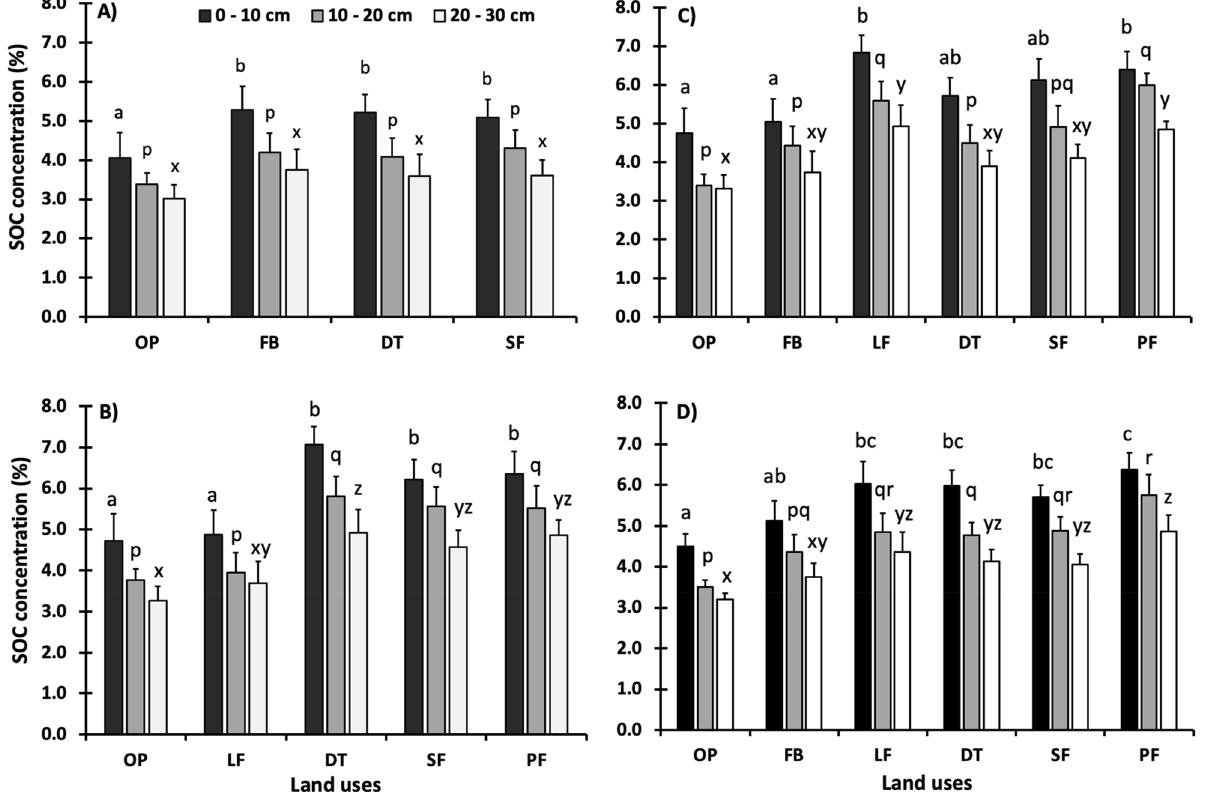
Figure 3. Soil organic carbon (SOC) content (%) across sampled land uses by soil depth category. ( A ) Jalisco, ( B ) Campeche, ( C ) Chiapas, ( D ) All regions. Lowercase letters above the bars indicate significant differences between land-uses in the same soil depth category. The y-axis shows SOC content (%) and the x-axis shows the different land-uses sampled, where OP = Open pasturelands, FB = Fodder banks, DT = Pasturelands with dispersed trees, LF = Live fences, SF = Secondary forests, PF = Primary